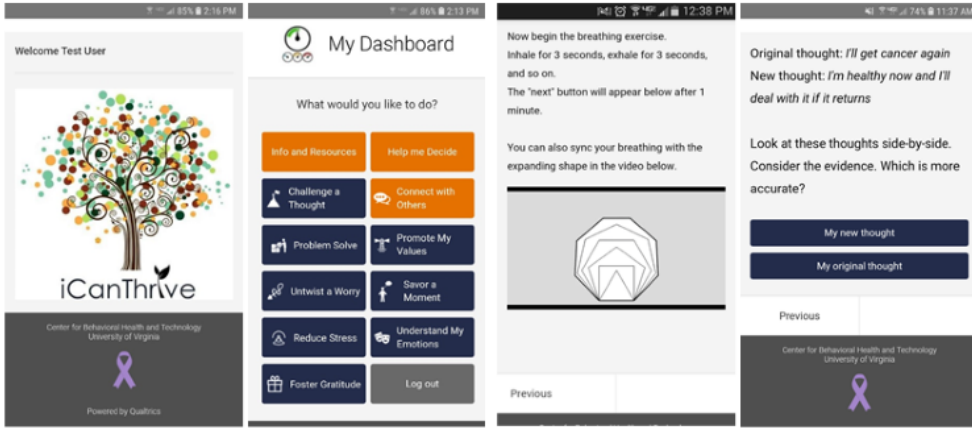
Figure 1. Screenshots of the iCanThrive